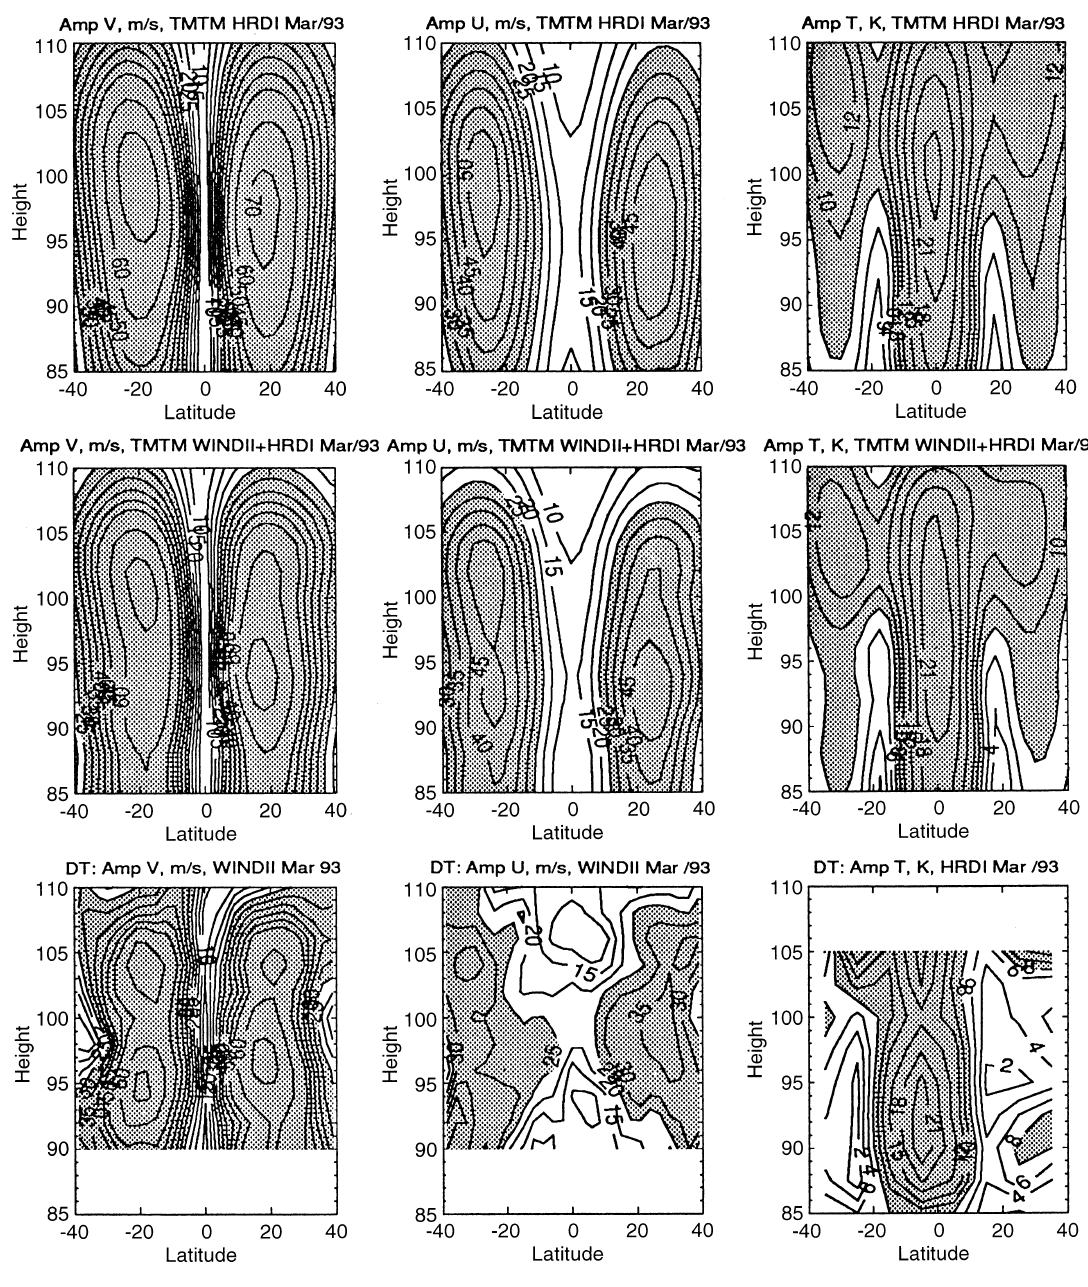
diurnal amplitudes of the meridional and zonal components estimated from WINDII observations (McLandress et al. , 1996a). Last plot in the third row is a least-squares fit to the